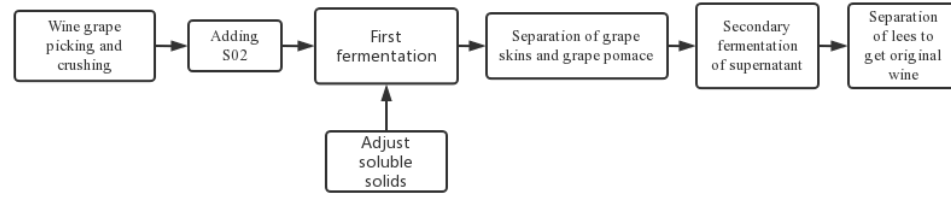
Figure 1. Fermentation flow chart for wine.